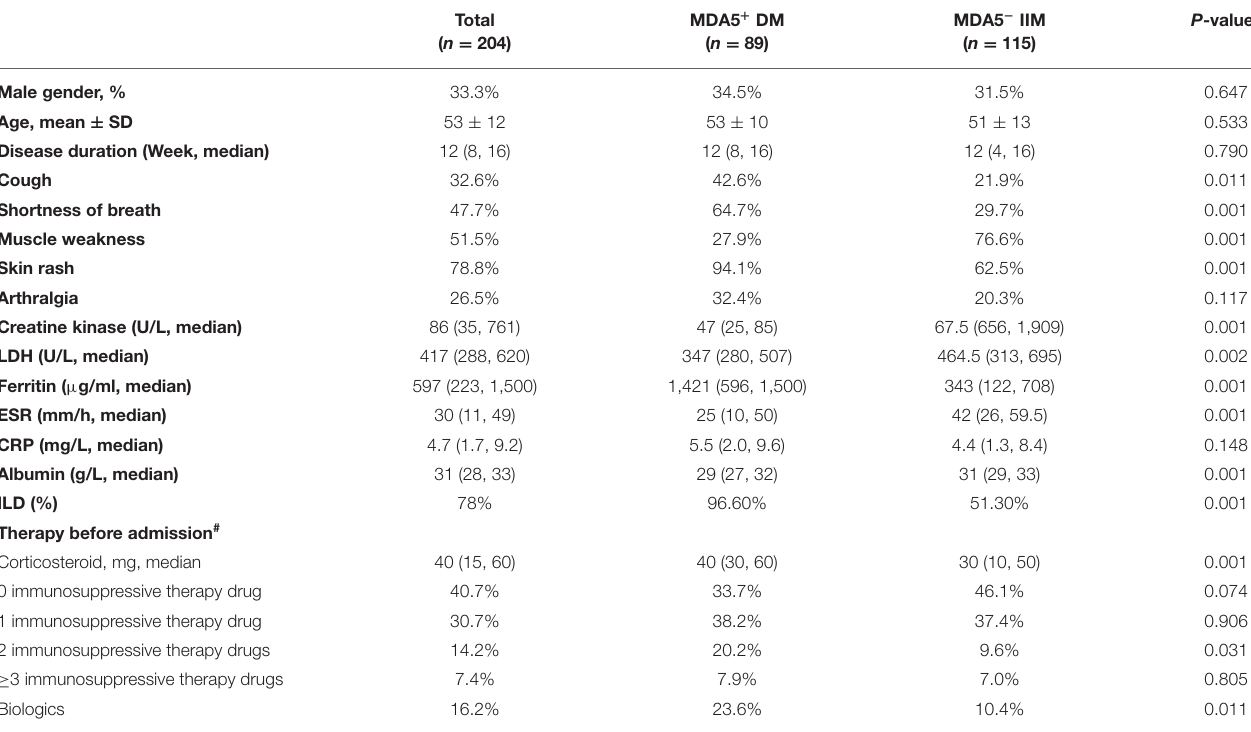
TABLE 1 | IIM Patients’